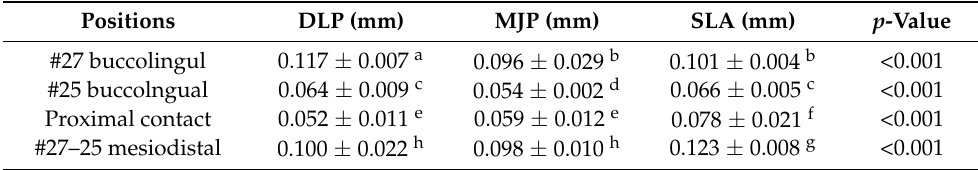
Table 2. The accuracy (trueness by RMS value (mean ± SD) mm) of 3D-printed models ( n = 36). Positions DLP (mm)